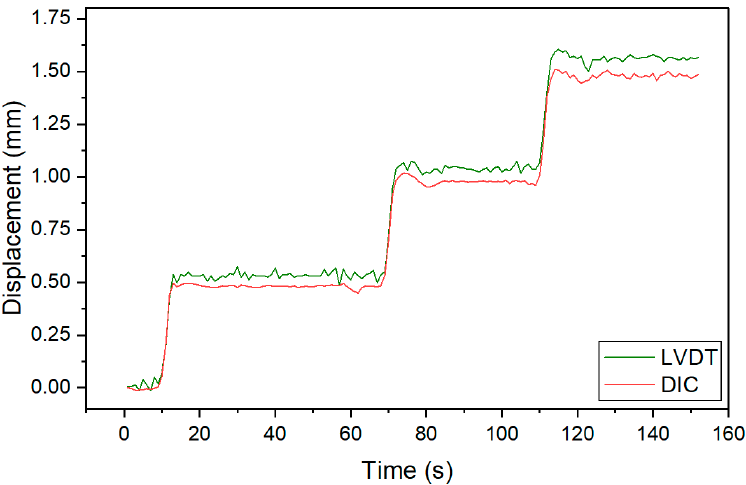
Figure 6. Comparison of the results of vertical displacements in the α‐α section. After each load change, there was a stability period during which measurement was taken with laser scanner. Tables 2 and 3 show a range of data obtained for different distances between the scanner and the object, the applied angle and resolution. No clear effect of the scanning settings on the obtained results was observed. The main factor that generated a measurement error was noise detected in data point clouds. Although the noise can be eliminated by manual analysis of the scan, it is time consuming. Table 2. Displacements from a distance of 5 m measured with the laser scanner.